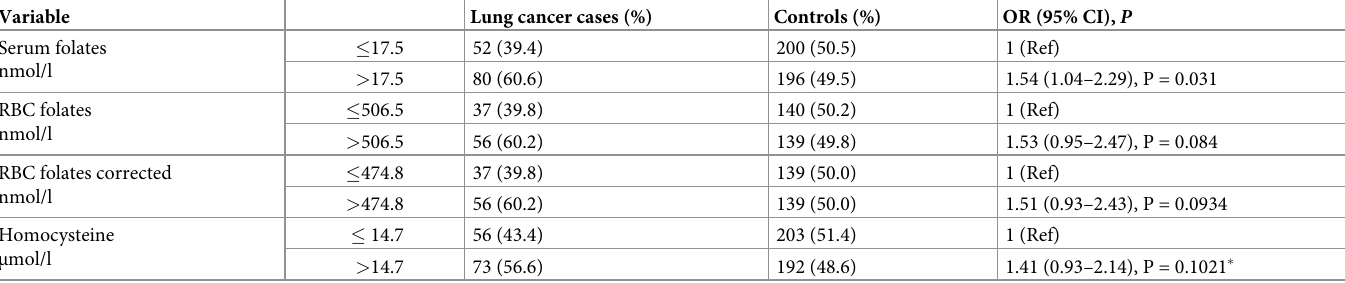
Table 2. Odds ratios of lung cancer occurrence in relation to serum folate, RBC folate and homocysteine levels, in study population from northern Poland, calcu- lated by conditional logistic regression with adjustment for sex, age and pack-years of smoking. Variable